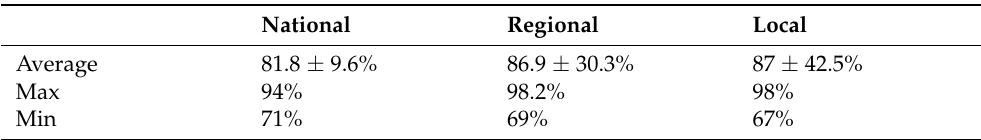
Table 4. Accuracy distribution depends on the study’s scale, with the average represented as the average value ± standard deviation. National Regional Local Average 81.8 ± 9.6% 86.9 ± 30.3% 87 ± 42.5% Max 94% 98.2% 98% Min 71% 69%